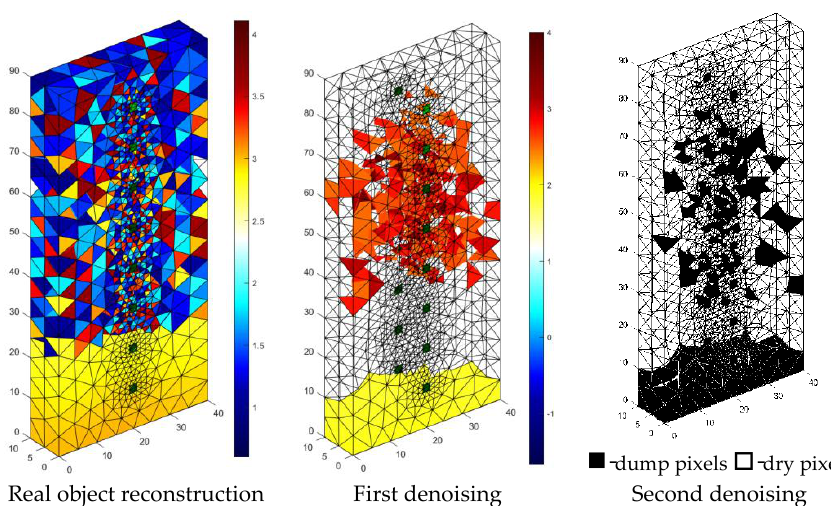
Figure 21. The result of the real object Artificial Neural Networks (ANN) moisture testing of the lightweight concrete block for the case of 2 × 8 electrodes.